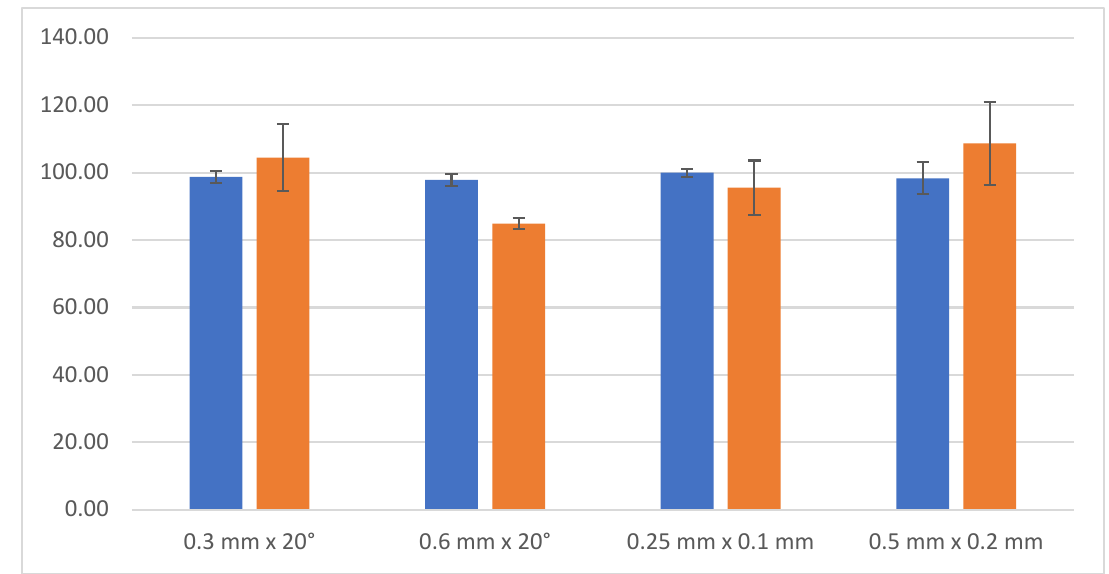
Figure 9. The percentage precision of the obtained cutting edge preparation.